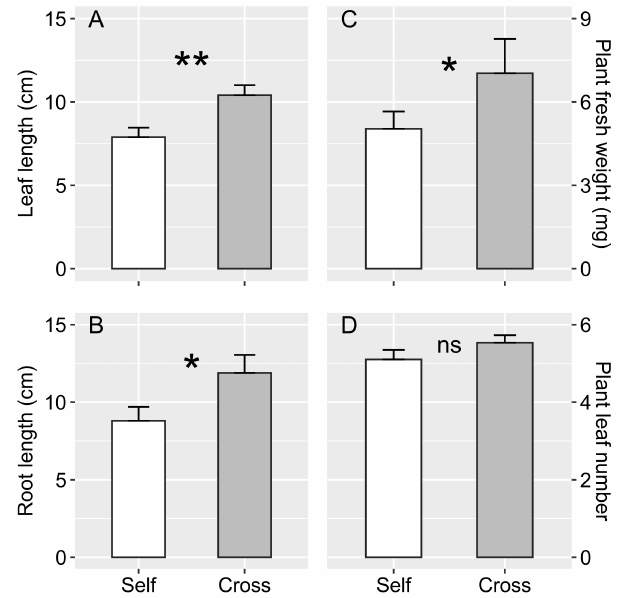
Figure 4. Sporelings growth traits of Isoëtes cangae generated by self-fertilization and cross- fertilization. Leaf length ( A ), root length ( B ), plant fresh weight ( C ), and plant leaf number ( D ) were measured after three months of plant cultivation in controlled conditions (see Material and Methods). Values are presented as the means ± confidence interval at p < 0.01 (n = 30). ‘ns’ represents non-significant; * and ** represent significant difference after Student’s t -test at p -values of 0.05 and 0.01,